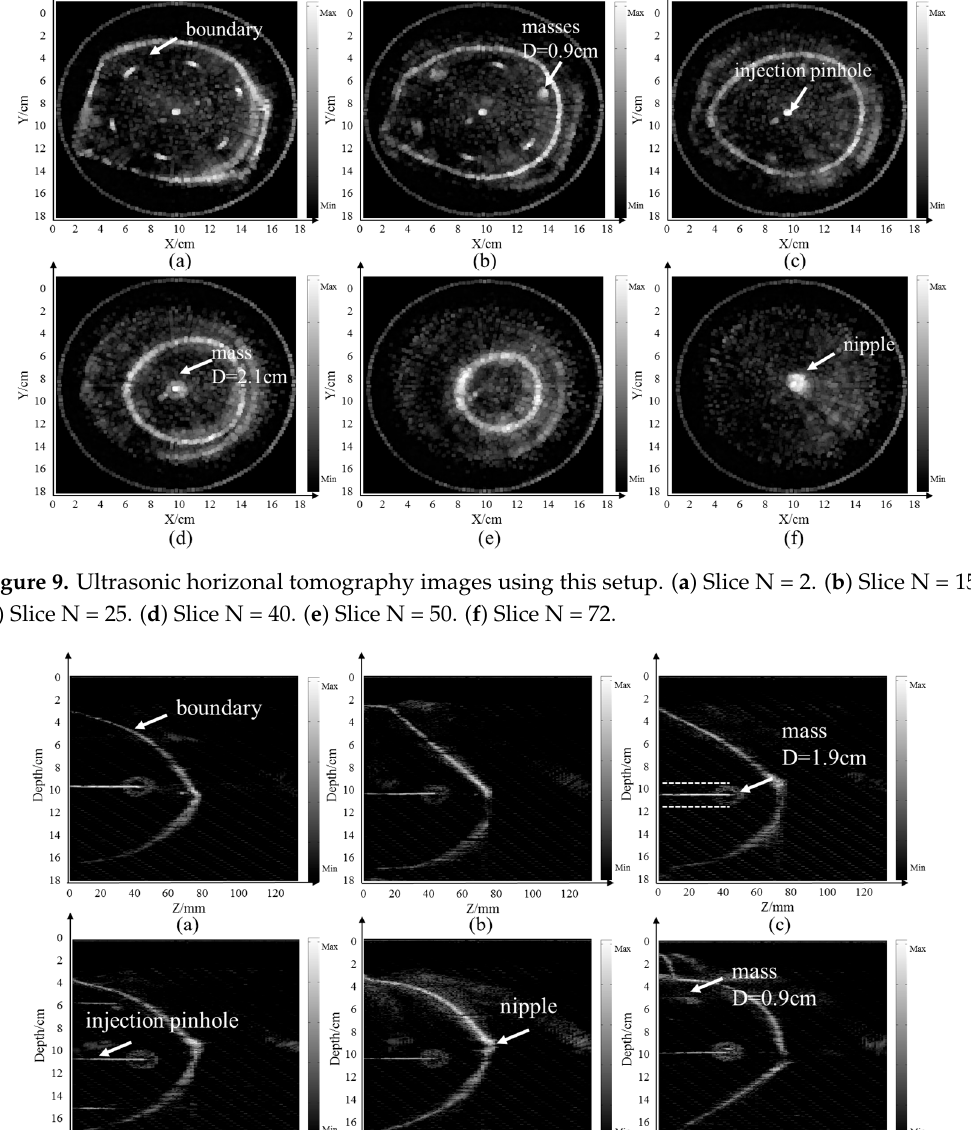
Figure 7. ( a ) Experimental setup. ( b ) PC workstation. ( c ) 64 channel ultrasonic signal receiving and transmitting circuits. ( d ) Diagram of the clinical imaging.